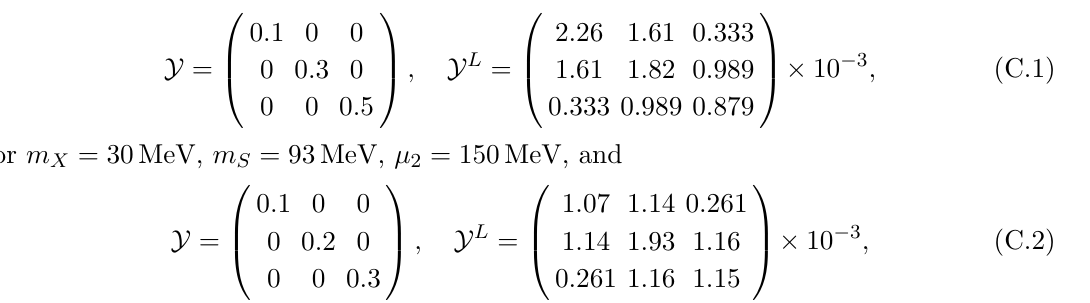
for m = 40 MeV, m = 128 MeV, (cid:22) = 320 MeV. One can check that eq. (C.1) and (C.2) 2 X S satisfy the SIMP condition ((cid:0) = (cid:0) ’ 10 4 and (cid:0) = (cid:0) ’ 10 3 ) as shown in the left 3 ! 2 2 ! 2 3 ! 2 kin and right panels of (cid:12)gure 7, respectively. These benchmark points give normal ordering neutrino mass eigenvalues and mixing angles consistent with neutrino oscillation data. It is also possible to take benchmark parameter sets in the cases for Y L (cid:28) Y R and inverted hierarchy, though these are not shown